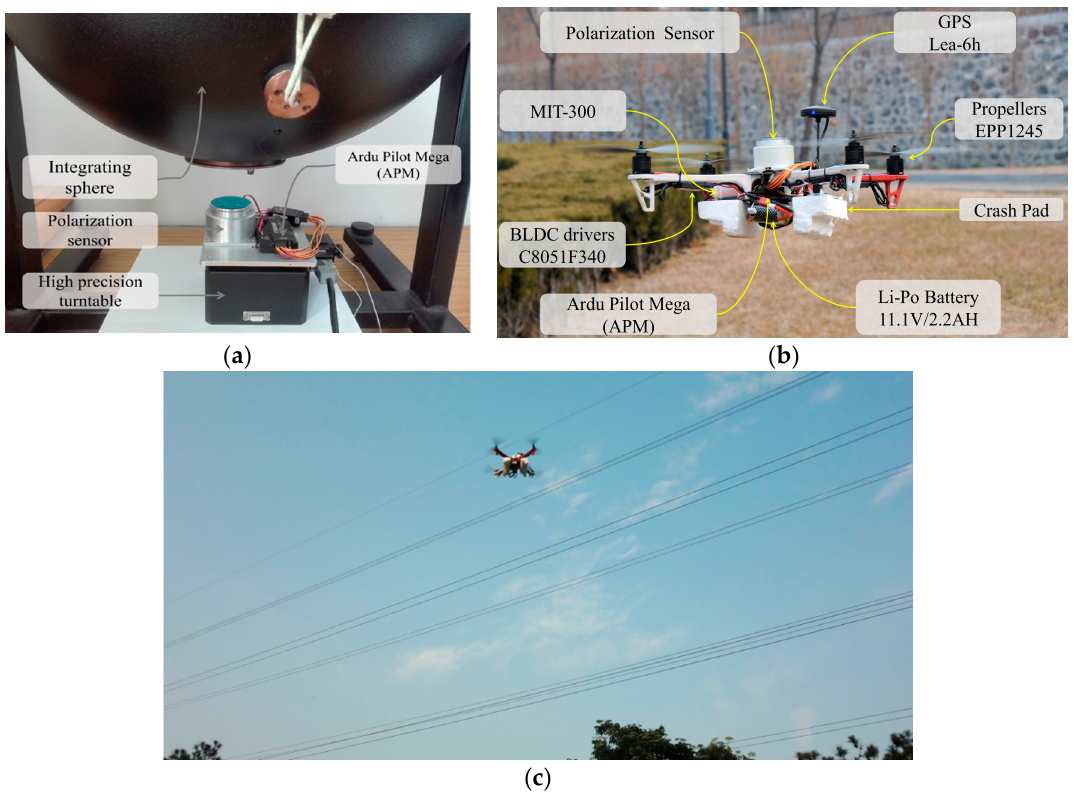
Figure 5. Experimental setup: ( a ) Indoor experimental setup; ( b ) Outdoor experimental setup; ( c ) The quad-rotor UAV flight near by the high voltage cables.